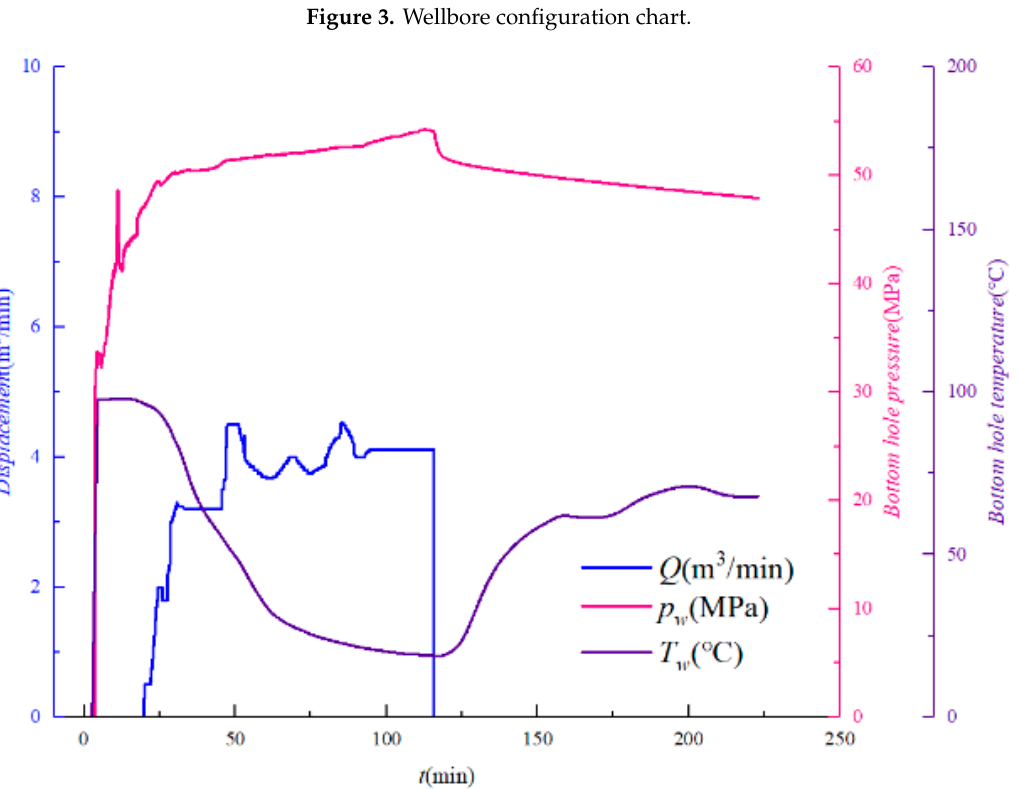
Figure 4. Curve of measured data at bottom hole during CO 2 fracturing. Table 1. Basic parameters for the model.